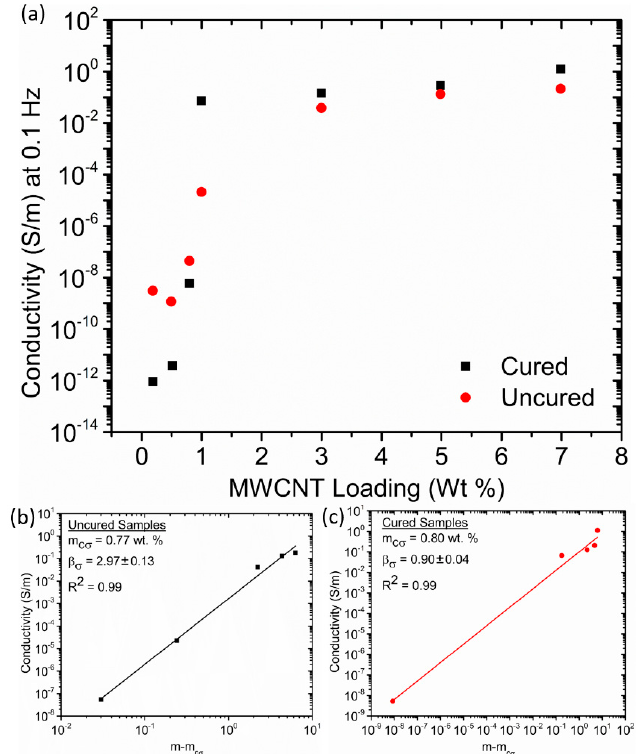
Figure 16. ( a ) Electrical conductivity at 0.1 Hz for uncured and cured MWCNT / PETI-330 composites Linear fits for determining the percolation threshold for the ( b ) uncured and ( c ) cured nanocomposites. Modified from